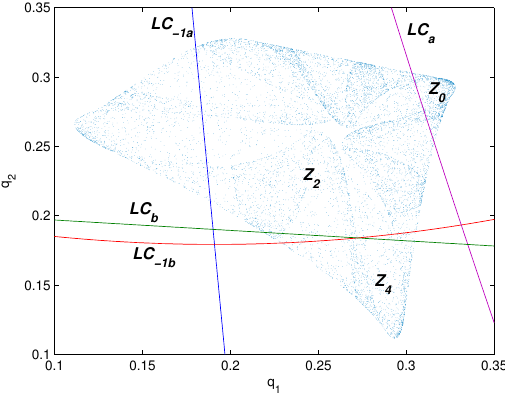
Figure 6. The critical curves at the parameters’ values a = 0.7, c = 0.1, b = 0.3 and k =